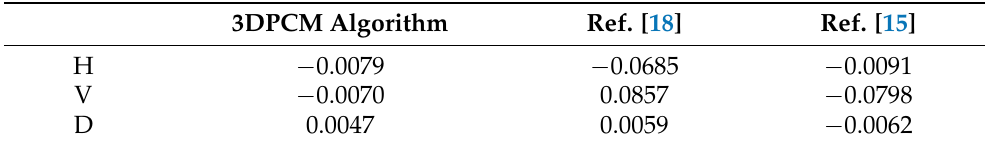
Table 6. Correlations between two neighbouring pixels in the enciphered image Lena ( 512 3DPCM algorithm, as well as new encipherment